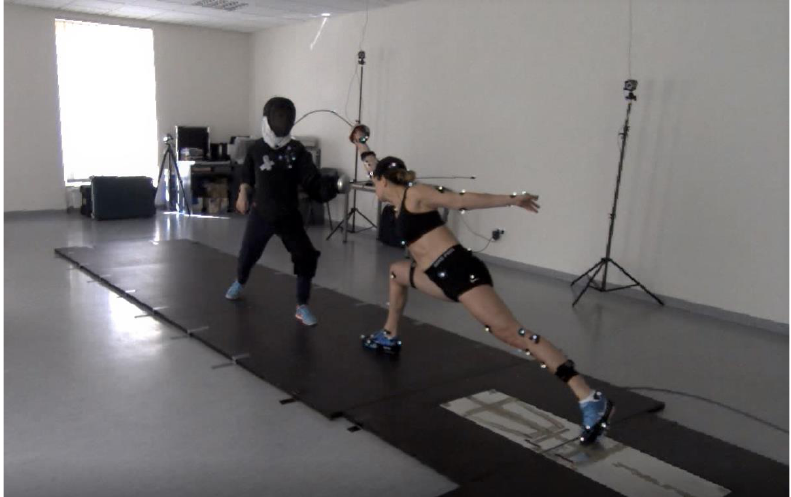
Figure 2. A lunge executed by the saber fencing world champion (Diagnostic Laboratory of the Department of Human Movements, Opole University of Technology).